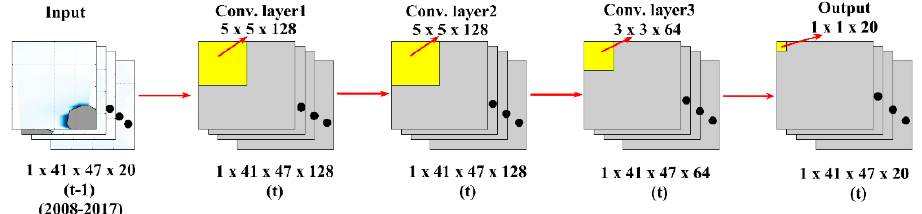
Figure 3. Schematic diagram of convolutional neural networks (CNNs) network structure. The yellow square represents the convolution kernel, and the gray square represents the feature map extracted by the convolution kernel.